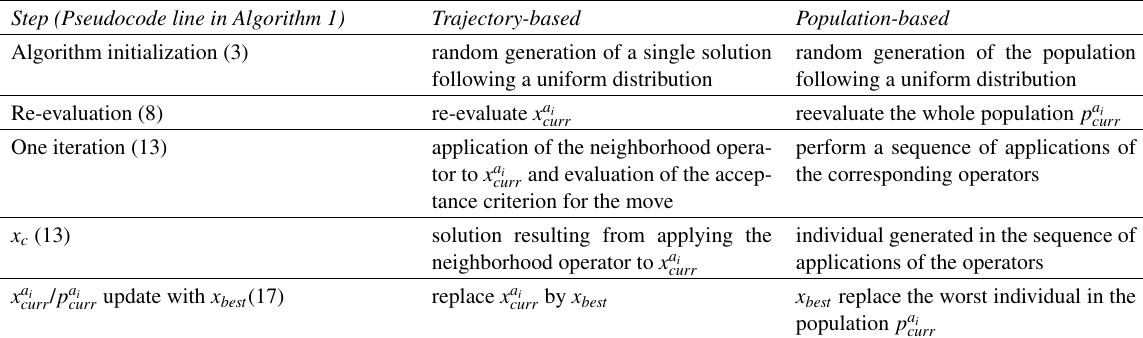
Algorithm portfolio based scheme for dynamic optimization problems Table 1. Details of the steps the algorithm portfolio accomplishes in a different way depending on whether the selected algorithm is trajectory-based or